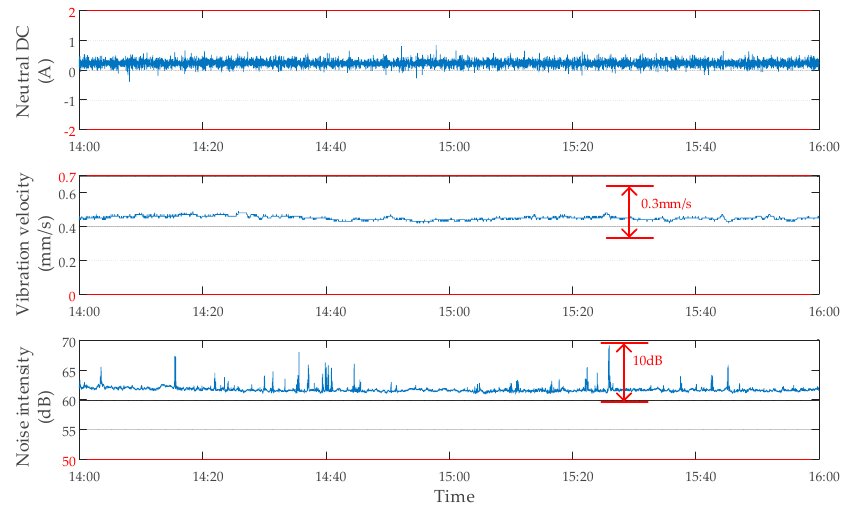
Figure 8. The data characteristics of a transformer with DC bias and suppression device on.